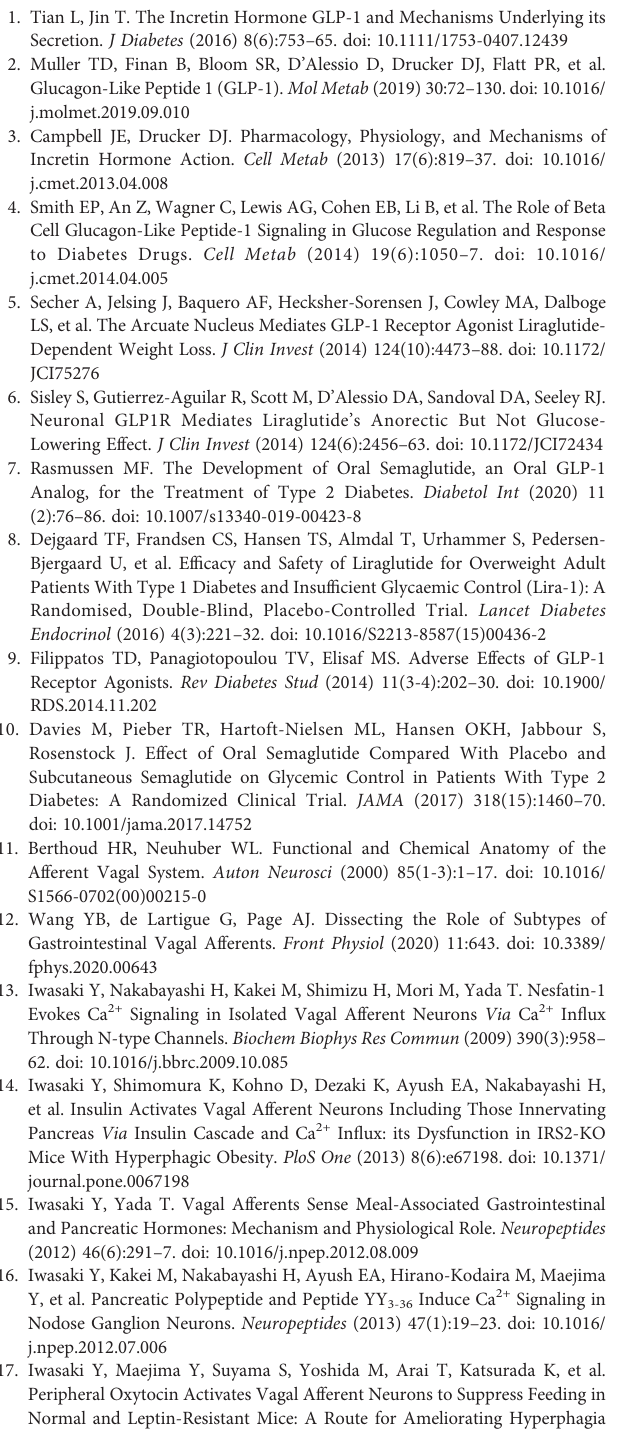
B ; Atgl, C ; Hsl) in epididymal WAT derived from DIO mice treated with ISF at LP onset for 10 days. (D, E) Uncoupling protein-1 (UCP-1) protein expression in interscapular BAT. n = 5. * p < 0.05 and ** p < 0.01 by unpaired t